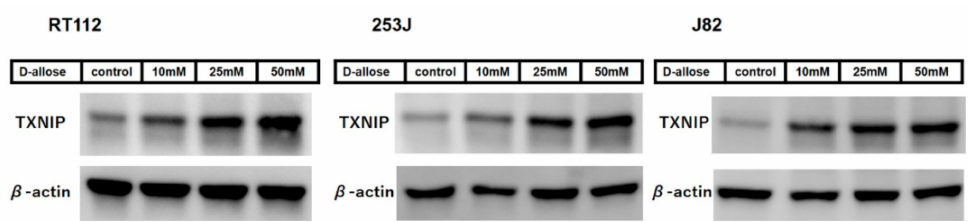
Figure 2. D-allose up-regulated thioredoxin binding protein (TXNIP) in three bladder cancer cell lines at 48 h post-treatment with varying concentrations of D-allose (10, 25, and 50 mM). Western blotting revealed that D-allose up-regulates TXNIP expression in RT112, 253J, and J82 bladder cancer cell lines in a dose-dependent manner. β -actin served as the loading